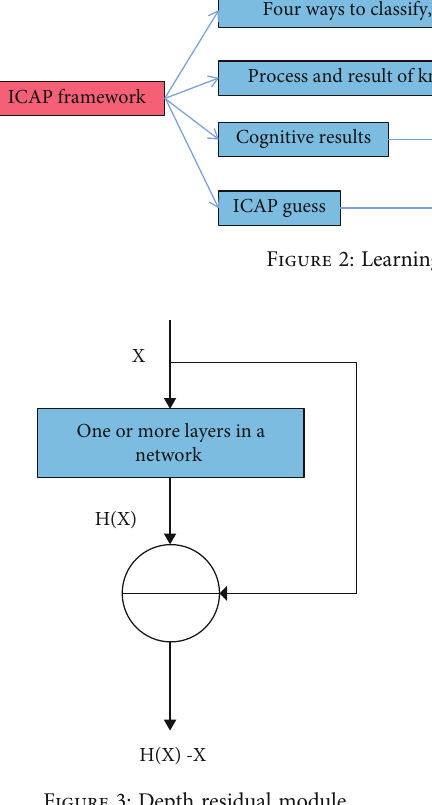
Figure 3: Depth residual